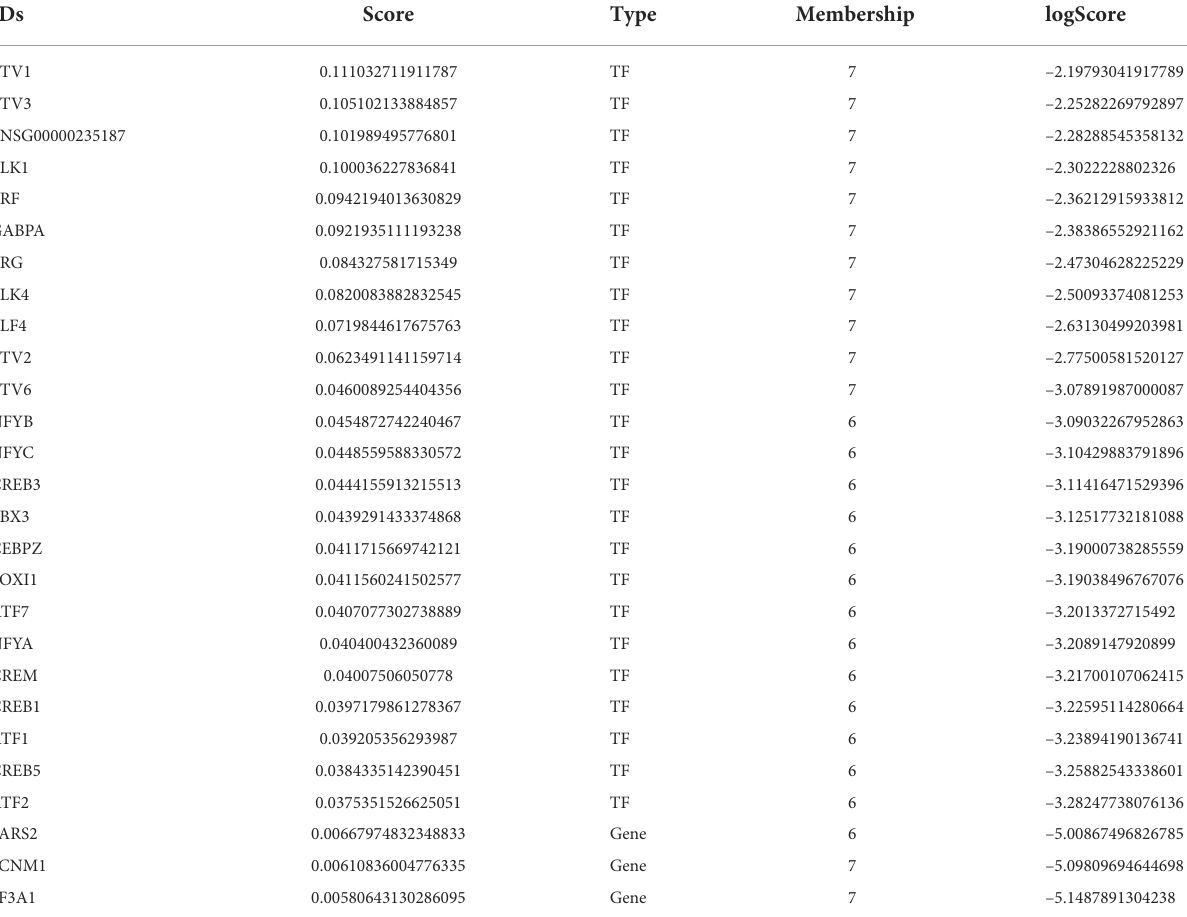
TABLE 1 Male-biased TFs and genes with the highest contribution to differential